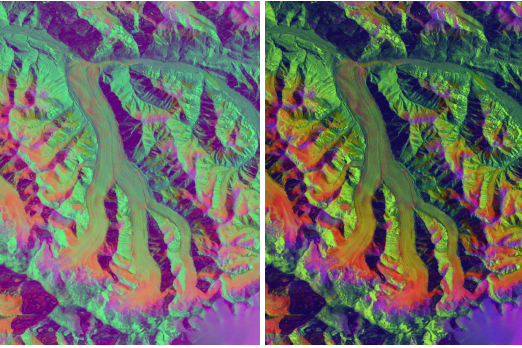
Figure 4. Comparison of PCA (Left) and CAE (Right) visualisation schemes on a longer period 2015-2017 on Kyagar